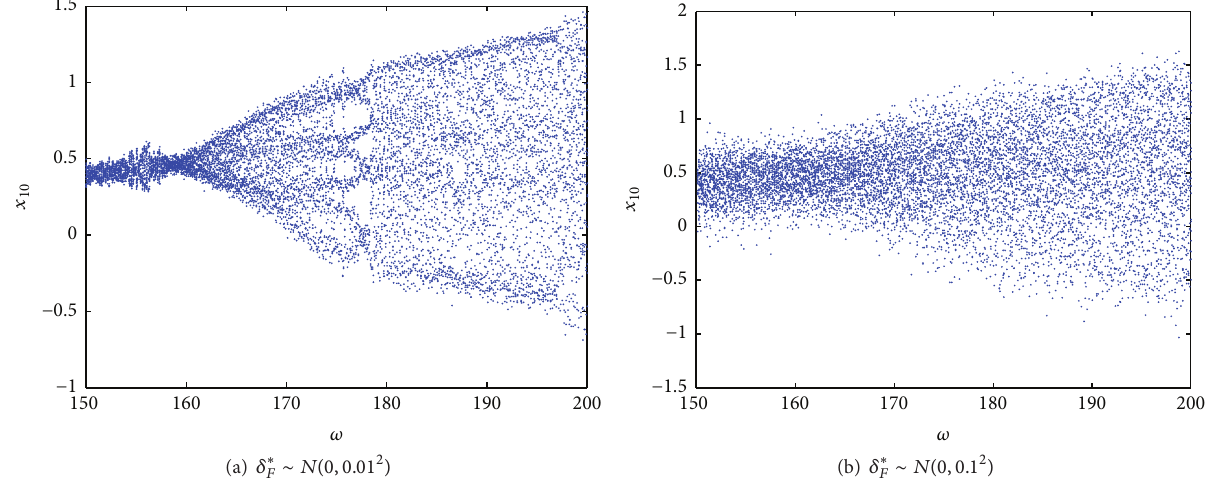
Figure 19: Bifurcation diagrams with random